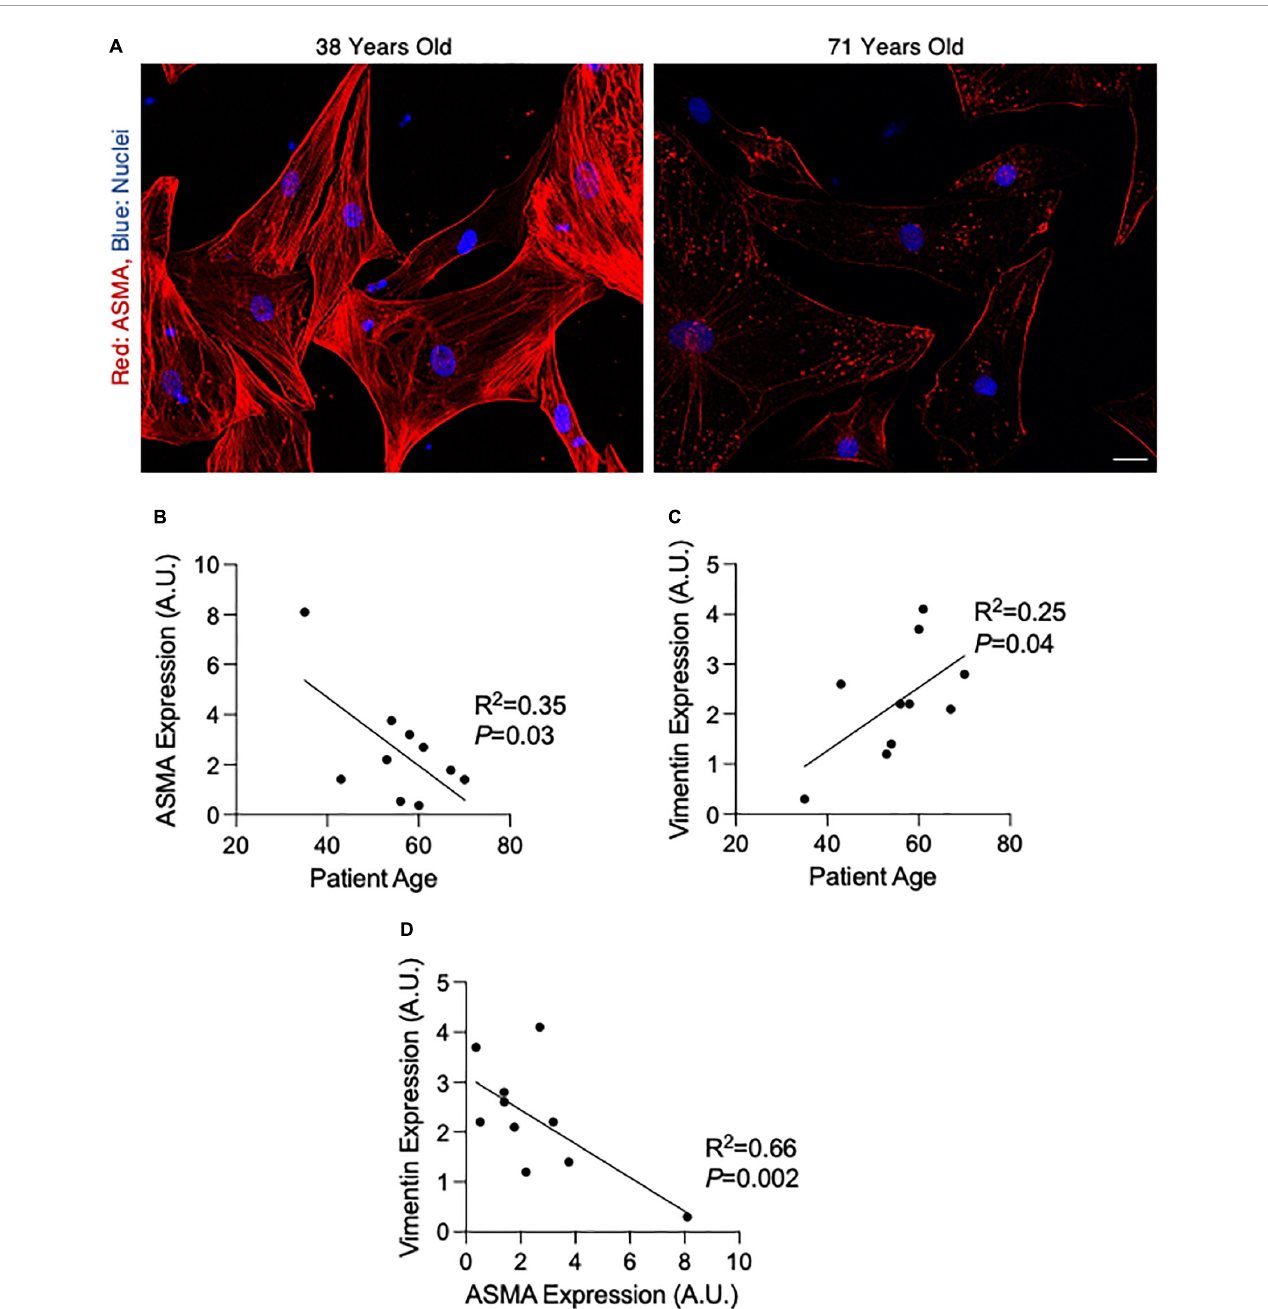
FIGURE2 Alpha-smooth muscle actin (ASMA) decreases and vimentin increases with age in smooth muscle cells (SMCs) isolated from non-dilated ascending aortas. (A) Fluorescent micrographs of cultured SMCs from a 38 year old (left) and 71 year old (right) patient. Red, ASMA; blue, nuclei. Scalebar = 10 µ m. (B,C) Graphs depicting the linear relationship between patient age and ASMA (B) or Vimentin (C) expression in cultured aortic SMCs. (D) Graph depicting the relationship between ASMA and vimentin expression in cultured aortic SMCs. A.U., arbitrary units; expression values were calculated by measuring fluorescence